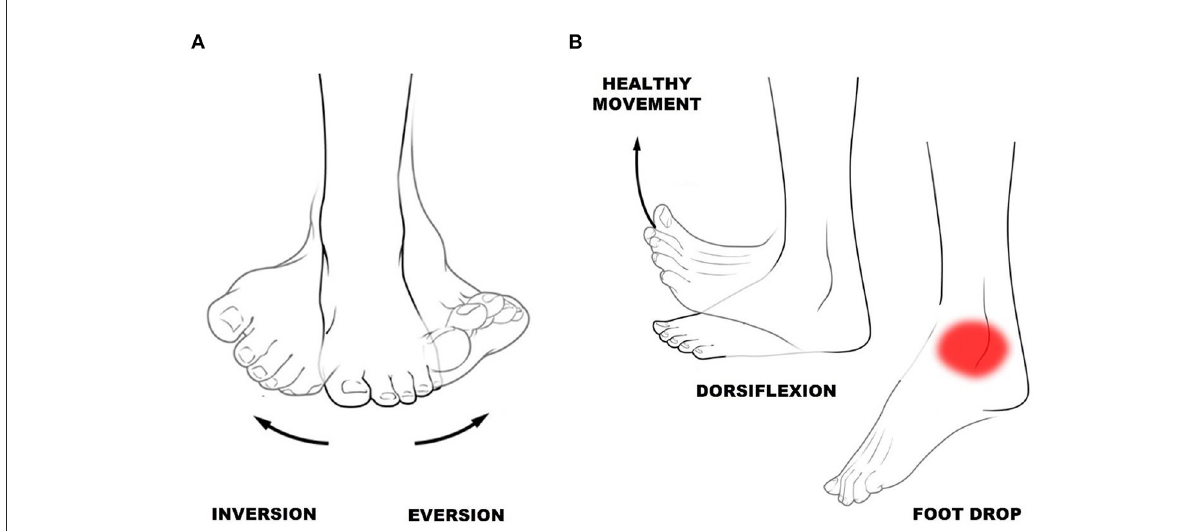
FIGURE1 (A) Ankle inversion and eversion. (B) Ankle dorsiflexion—toes toward shins, and foot drop—difficulty lifting the